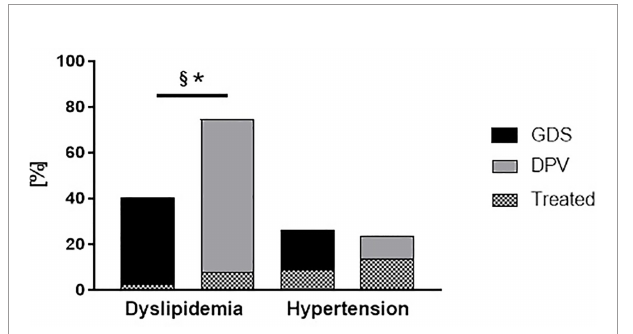
FIGURE 3 | Prevalence and management of hypertension and dyslipidemia in patients with newly diagnosed type 1 diabetes from the GDS and DPV cohorts. Prevalence and management of modi fi able cardiovascular risk factors (dyslipidemia and hypertension) in patients with newly diagnosed type 1 diabetes from the GDS (black) and DPV (grey) cohort. ‘ Treated ’ refers to the frequency of lipid-lowering medication or antihypertensive, respectively. Data are expressed as percent from the total number of measured participants in each cohort. P values refer to comparison of unadjusted data. *p < 0.05 regarding the prevalence of comorbidities; § p < 0.05 regarding the percentage of treated patients.